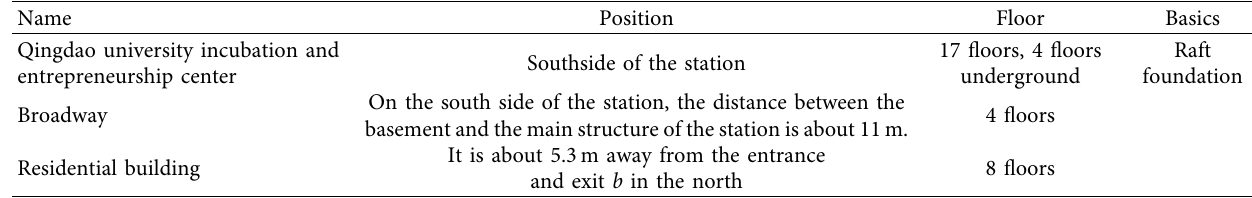
Table 13: List of surrounding buildings.